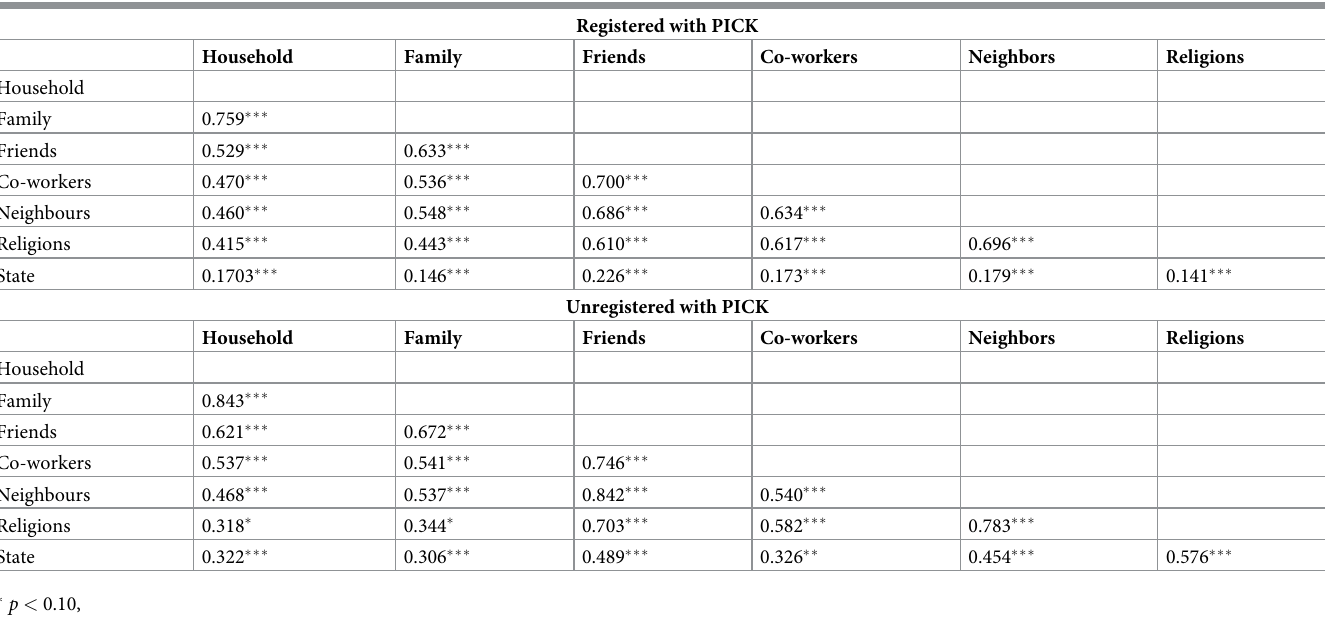
Table 4. Pair-wise correlations of vaccination registration expectations across social